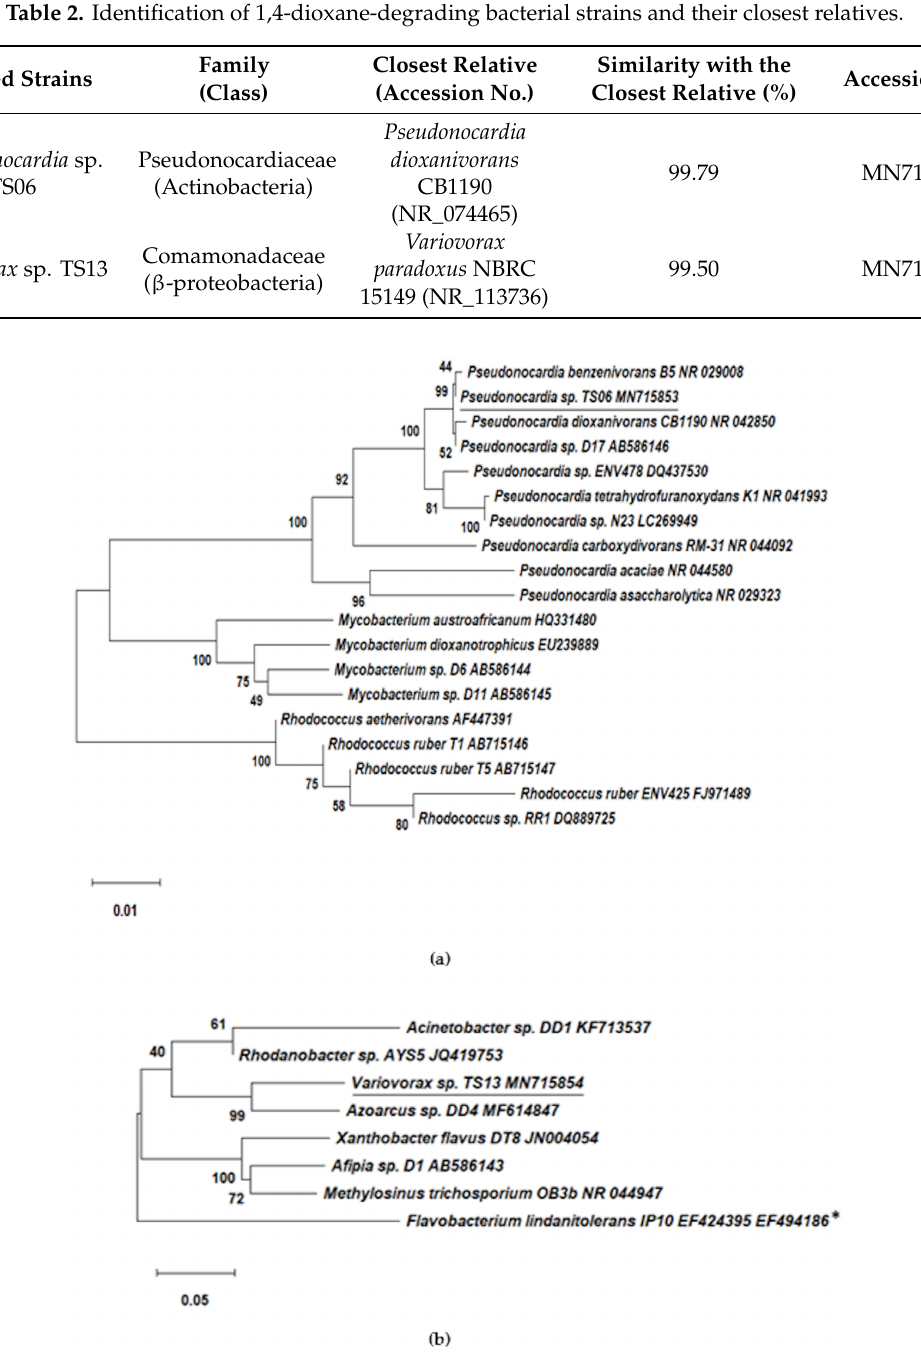
Figure 2. Neighbor-joining phylogenetic tree of ( a ) Pseudonocardia sp. TS06 (underlined) with previously reported gram-positive 1,4-dioxane-degraders and ( b ) Variovorax sp. TS13 (underlined), with previously identified gram-negative 1,4-dioxane-degraders. The bootstrap values were based on 1000